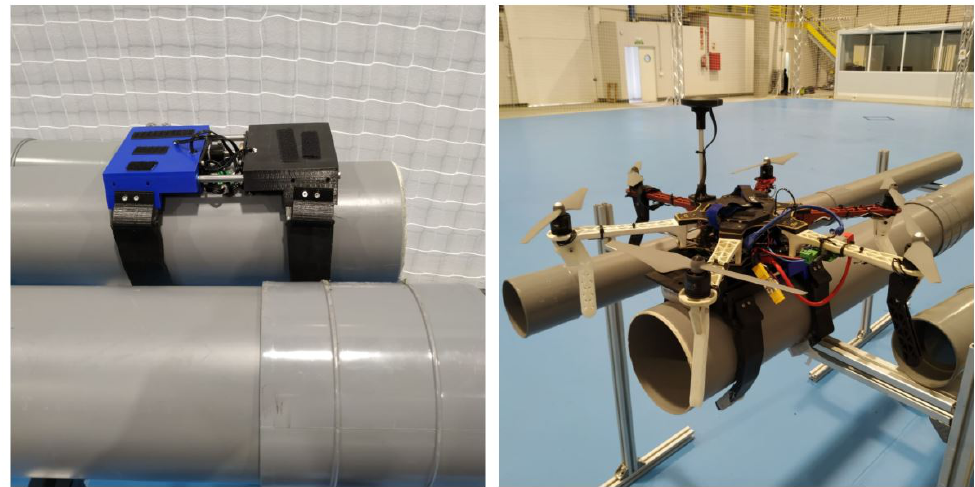
Figure 17. The image on the left-hand side shows the first experiment performed with the landing gear alone on the pipe. The picture on the right-hand side shows the complete system and how it is attached to the pipe.